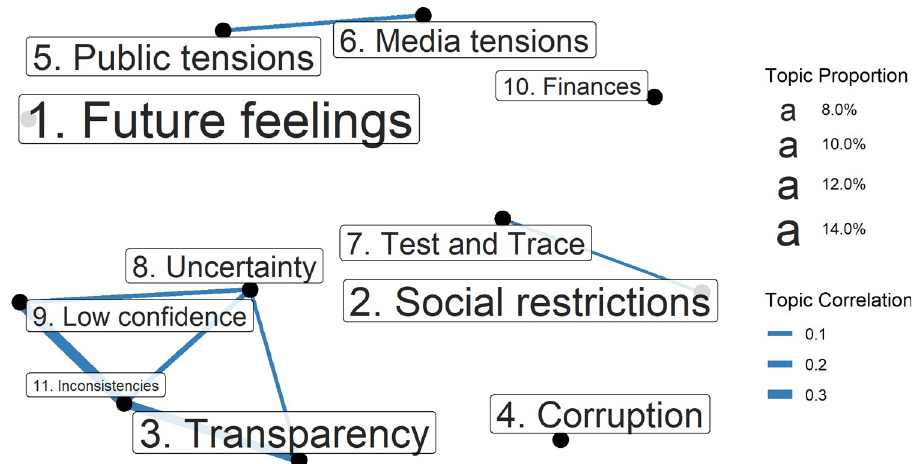
Fig 3. Correlation between topics. Correlations shown where ρ >